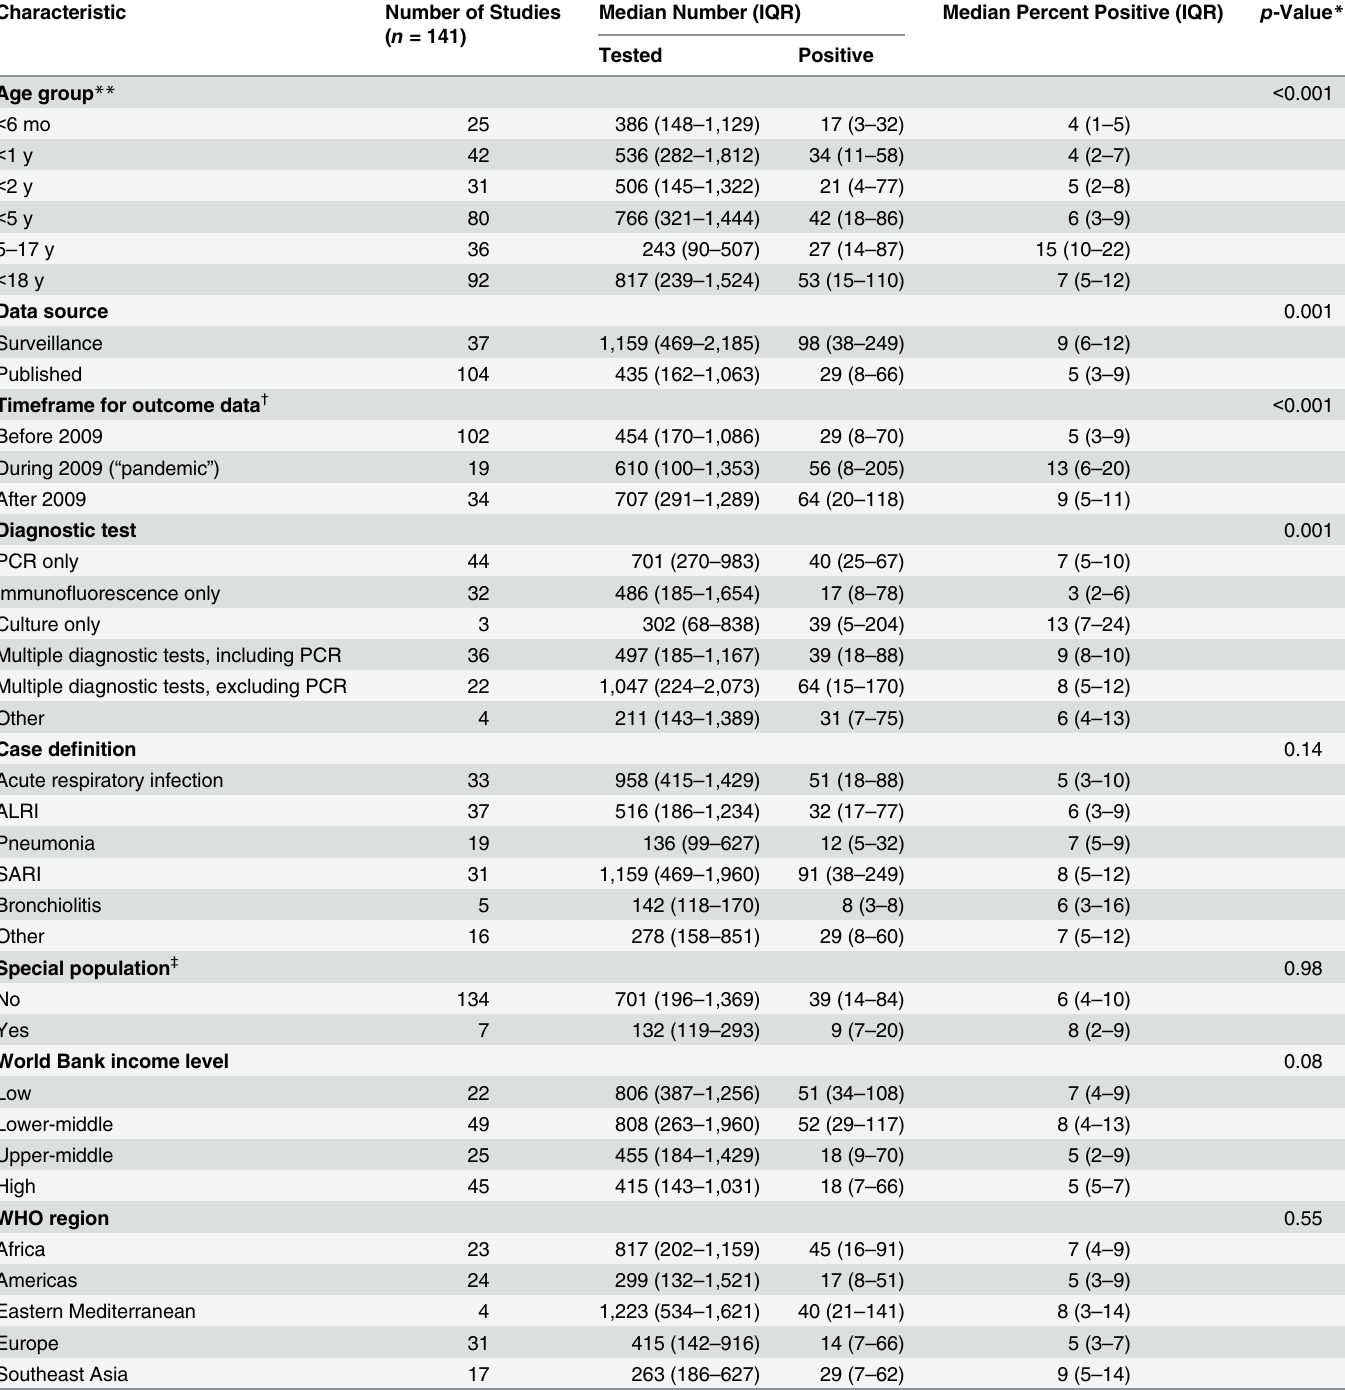
Table 2. Crude proportion of respiratory samples from hospitalized children testing positive for influenza by age group, study design, and population.